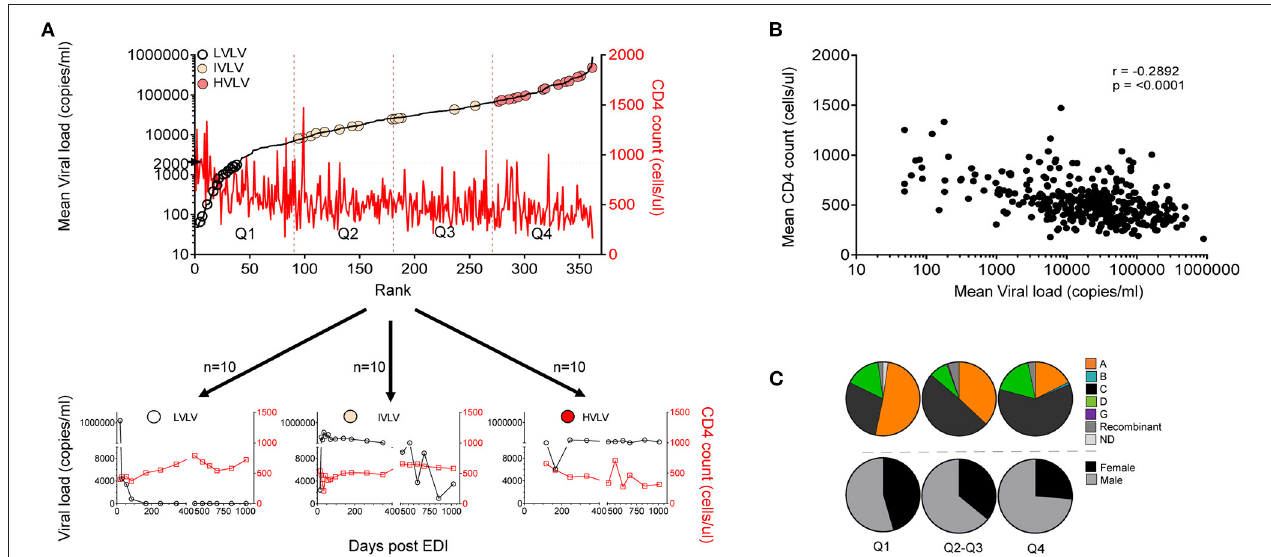
FIGURE 2 | (A) Ranks of set point VL calculated for 362 volunteers between 9 and 36 months post infection showing distribution of Low viral load volunteers (LVLVs), Intermediate viral load volunteers (IVLVs) and High viral load volunteers (HVLVs). Ranked dataset was also divided into equal quartiles based on set point viral load. (B) Set point VL correlates inversely with mean CD4 counts calculated over the same period (Pearson’s r = − 0.2892; p < 0.0001). (C) Subtype and gender distribution of ART naïve volunteers by quartiles of the ranked dataset. Infecting subtype and gender both have a relationship with set point